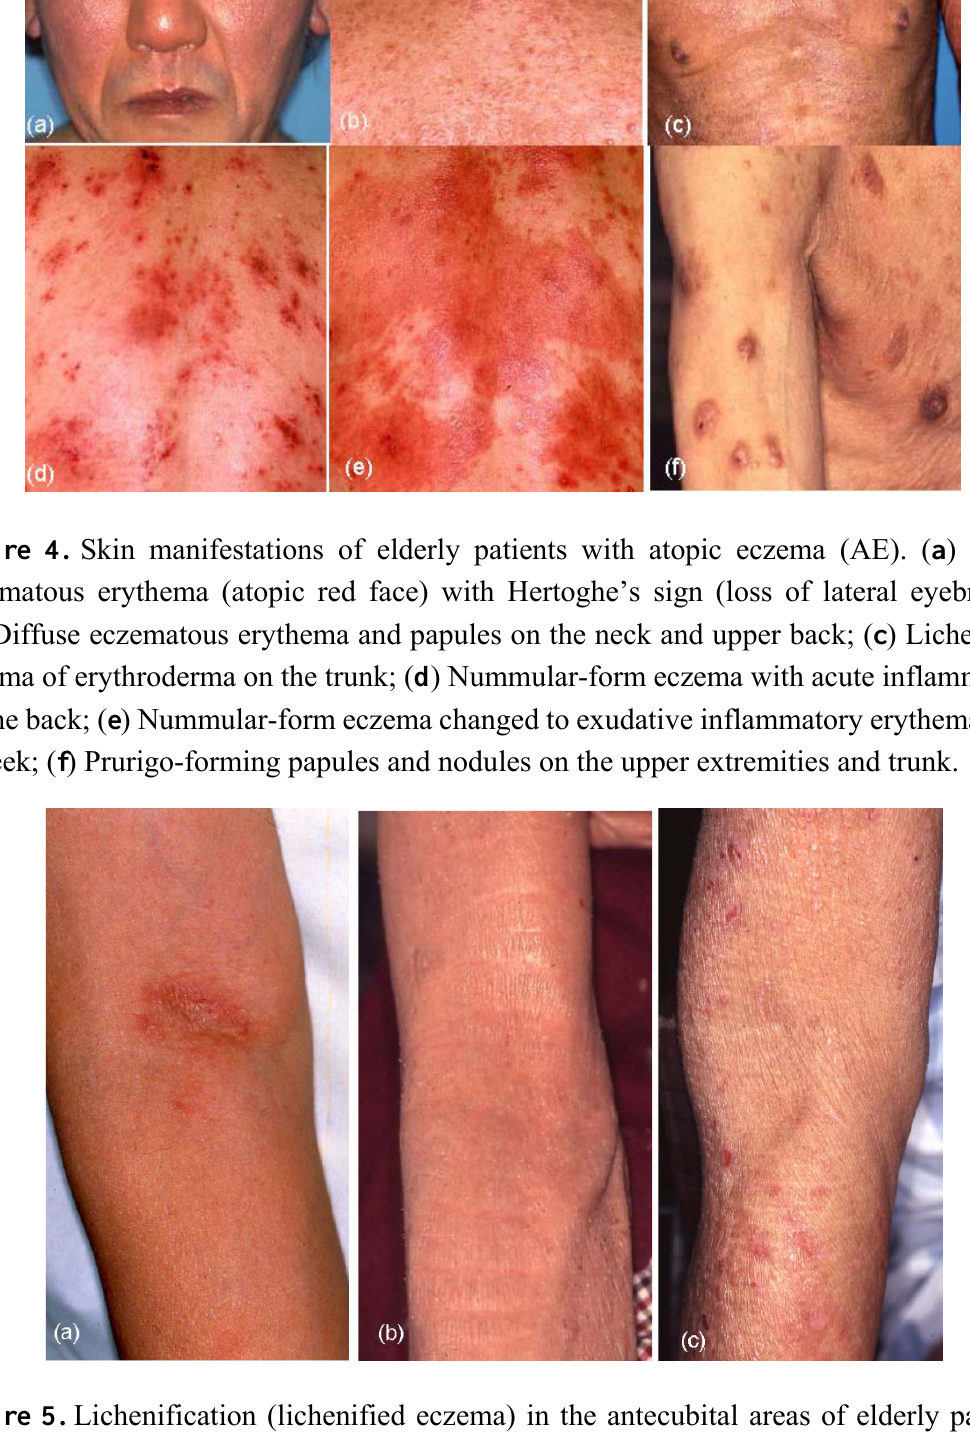
Figure 5. Lichenification (lichenified eczema) in the antecubital areas of elderly patients with atopic eczema (AE). ( a ) Localized lichenified eczema in the elbow fold; ( b ) Diffuse lichenified eczema in the elbow fold and flexure site of the arm; ( c ) Lichenified eczema around the scarcely involved elbow fold (reverse